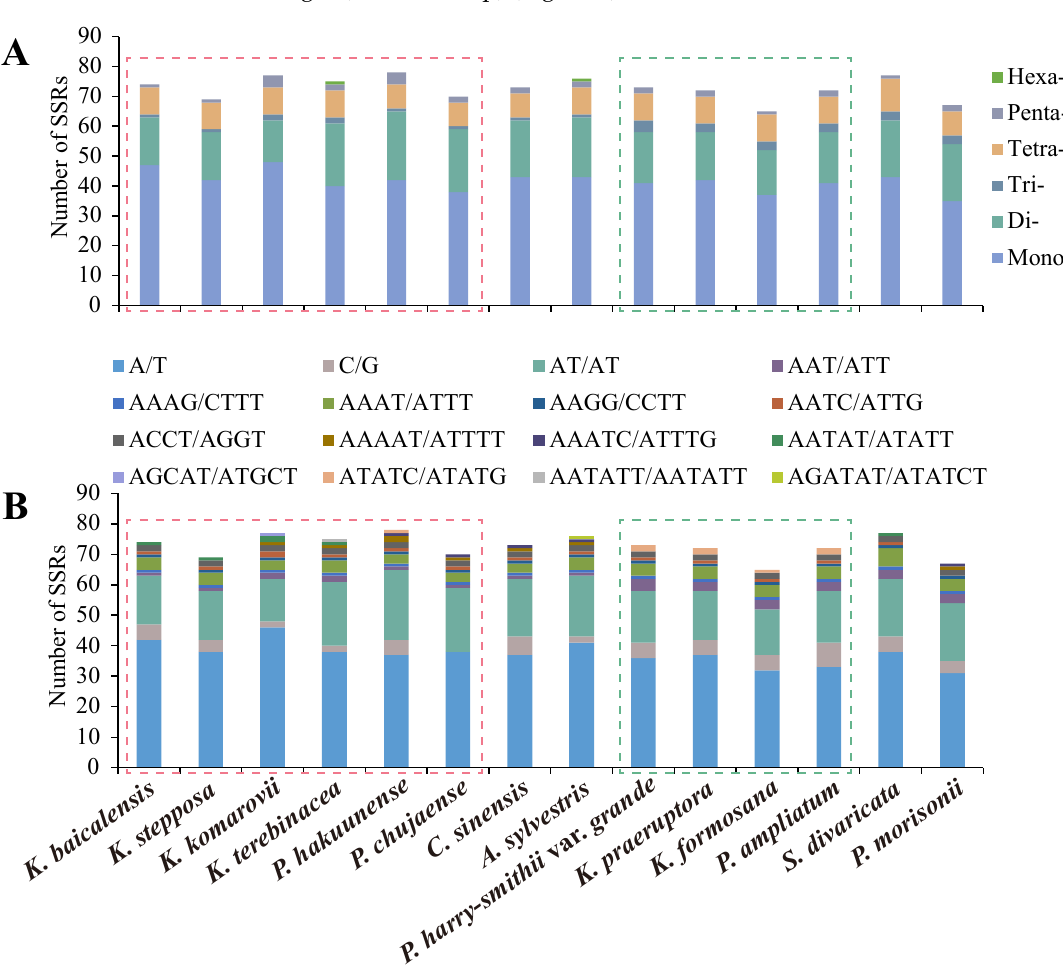
Figure 2. Comparison of simple sequence repeats (SSRs) in the 14 plastomes of Kitagawia and related taxa. ( A ) number of six types of SSRs; ( B ) number of all repeat motifs of identified SSRs. Boxes in pink and green are for Subclade I and Subclade II,